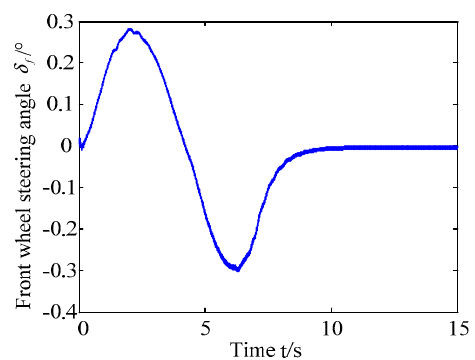
Figure 15. Longitudinal velocity of vehicle p .